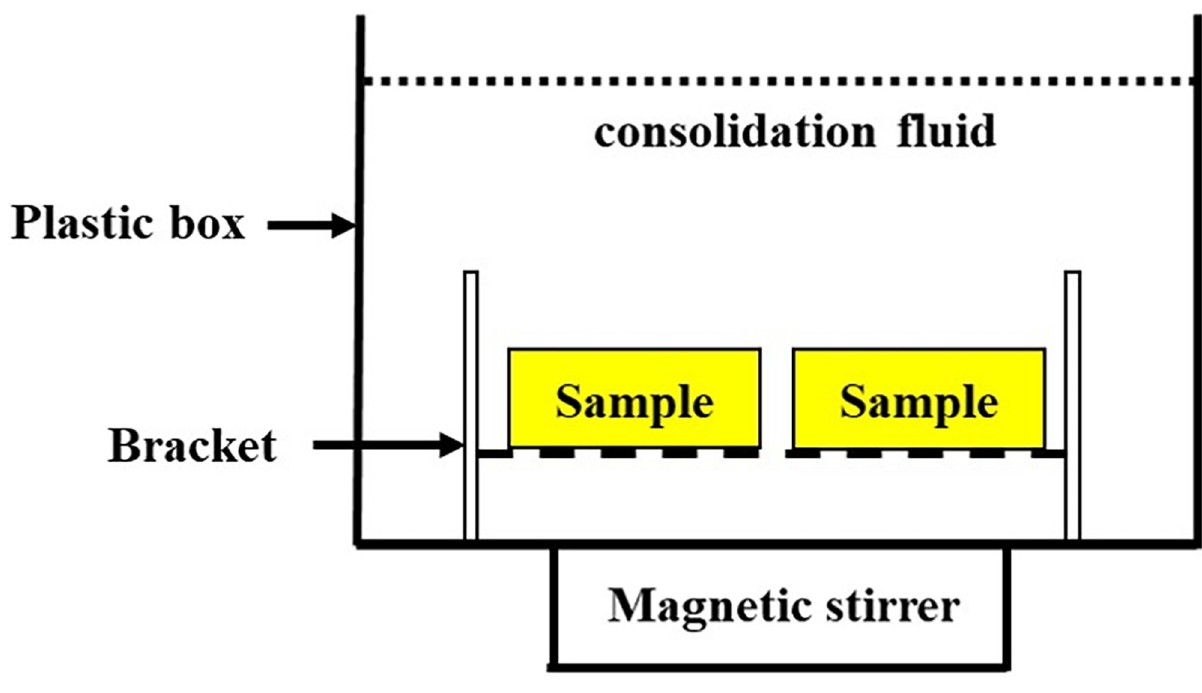
Fig 6. Immersion method.